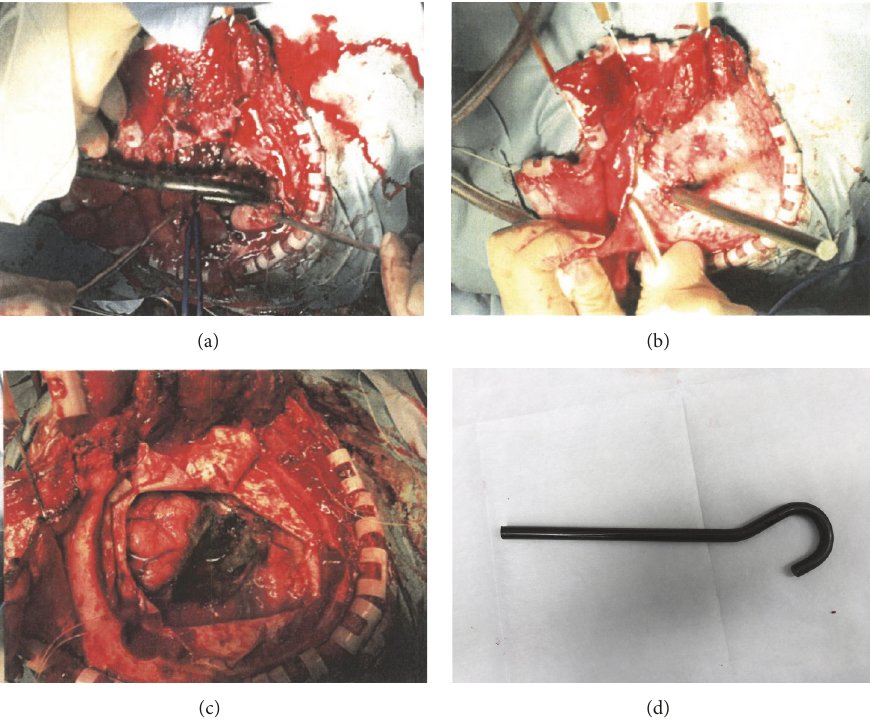
Figure 4: Intraoperative photographs. (a) Exposure of the metal bar after a semicircular incision. (b) The hook-shaped metal bar is shown to penetrate the frontal lobe without causing injuries to major arteries. (c) Neither bleeding nor hematoma was observed after removal. (d) The metal bar after surgical